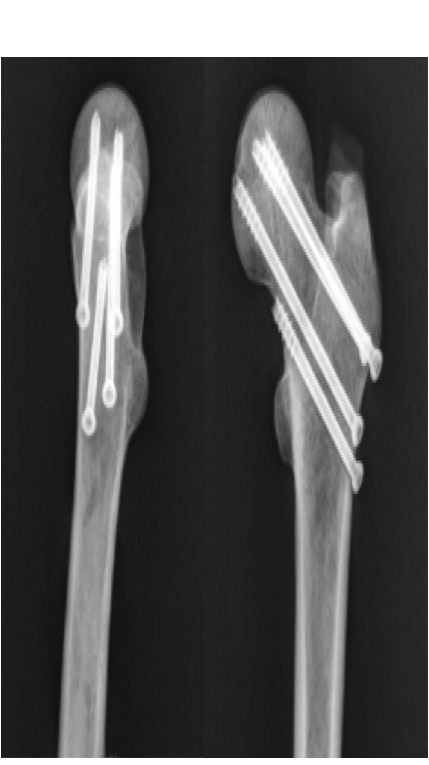
Figure 5. Medial femoral neck support screw combined with three cannulated compression screws (3CCS + mFNSS) ( Note : Positive and lateral X-ray film after internal